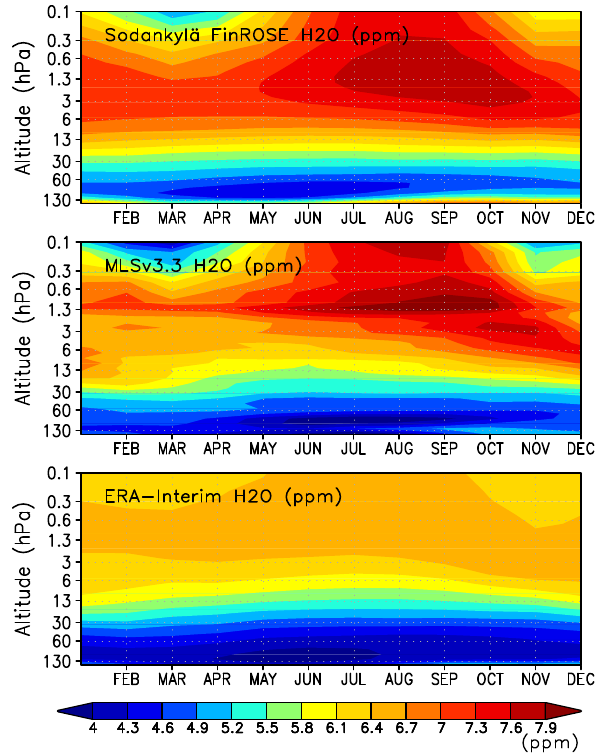
Figure 1. Climatology (2004–2014) of the water vapour distribution from FinROSE, MLS v3.3 data, and ECMWF ERA-Interim above